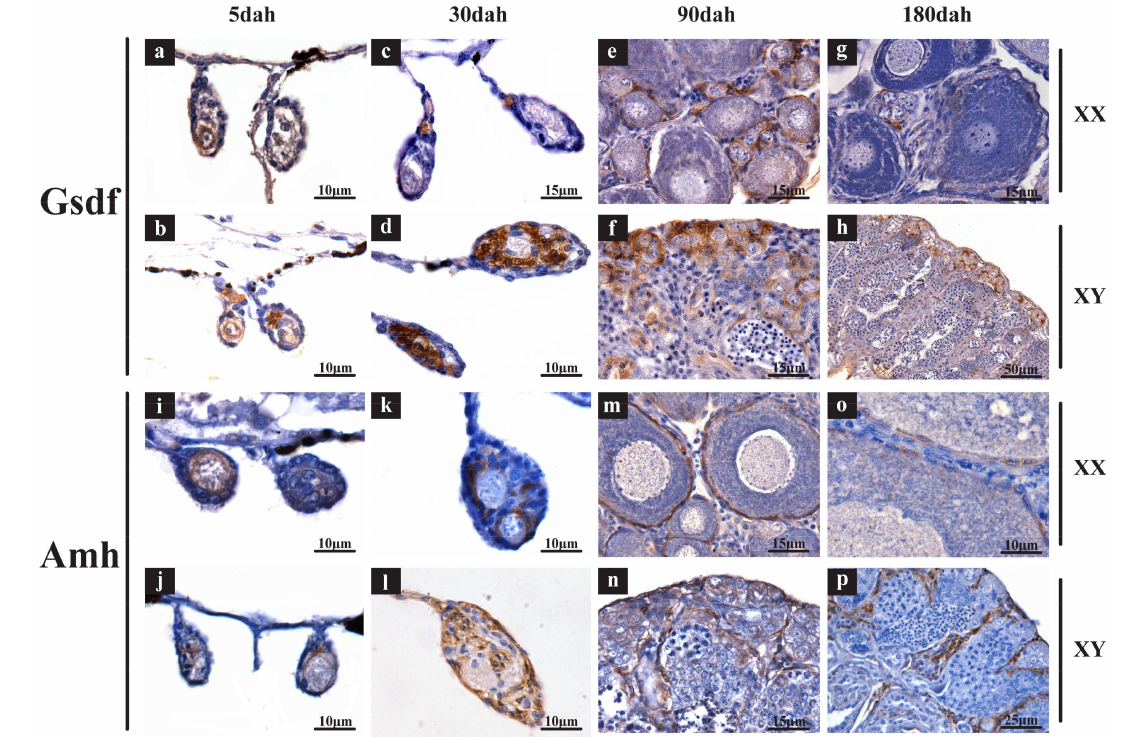
Figure 9. Cellular location of Gsdf and Amh in gonads by IHC. Gsdf-specific immunostaining was clearly observed in the somatic cells neighboring oogonia of XX gonads and Sertoli cells neighboring spermatogonia of the XY gonads at all stages ( a – h ). The Amh proteins were located in granule cells in ovary at all stages and somatic cells surrounding germ cells in the testis at 5 dah, and at later stages in myoid cells and Sertoli cells ( i – p ). Scale bar: ( a , b , d , i – l , o ) 10 µ m; ( c , e – g , m , n ) 15 µ m; ( p ) 25 µ m; ( h ) 50 µ